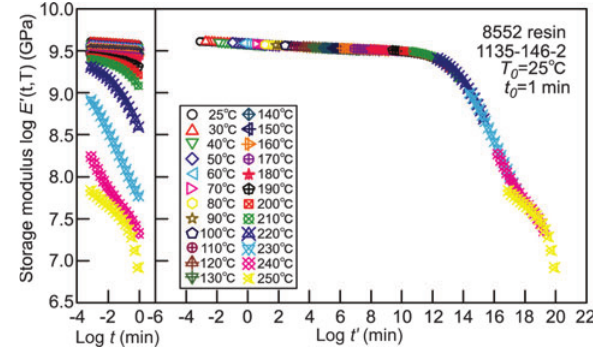
Figure 13 Horizontal time axis shift factor a tion of temperature for storage modulus master curve of Hexcel 8552 resin system (data generated by